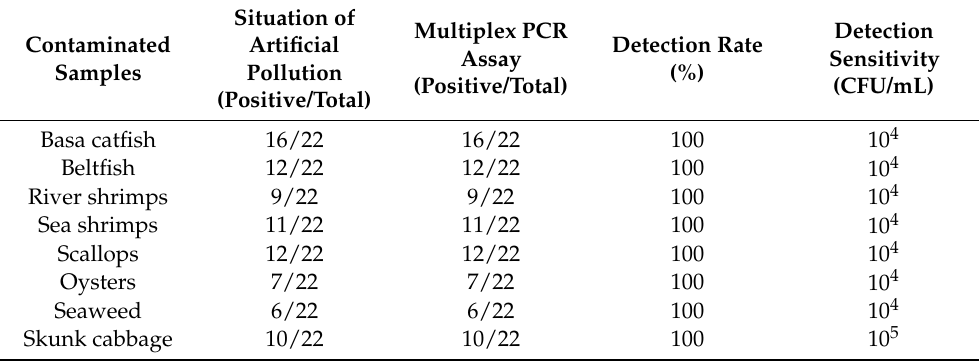
Table 5. Contamination of